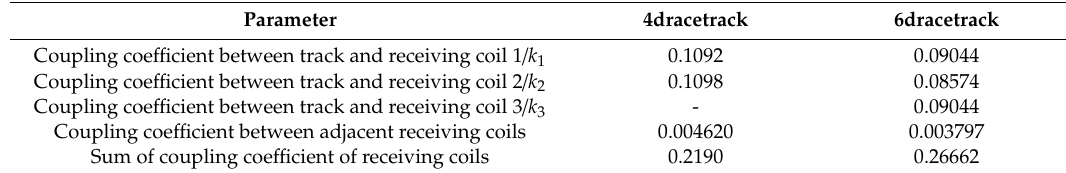
Figure 8. Models and magnetic field distribution of 2d, 4d, and 6d racetracks. Table 4. Coupling coe ffi cient of di ff erent receiving